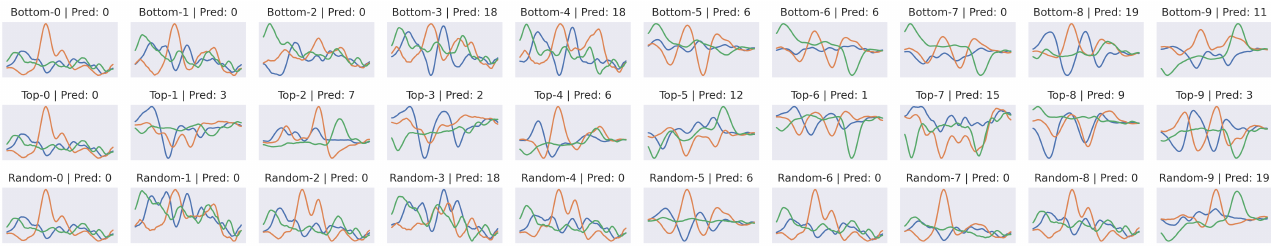
Figure 3. Sanity Attribution. Shows the attribution map of a CharacterTrajectories sample. Top-X: top-down randomization of X layers, Bottom-X: bottom-up randomization of X layers. Random-X: randomized layer/block X. Top-0 refers to the original attribution map. The results provide evidence that the TimeREISE method strongly depends on the model parameters.